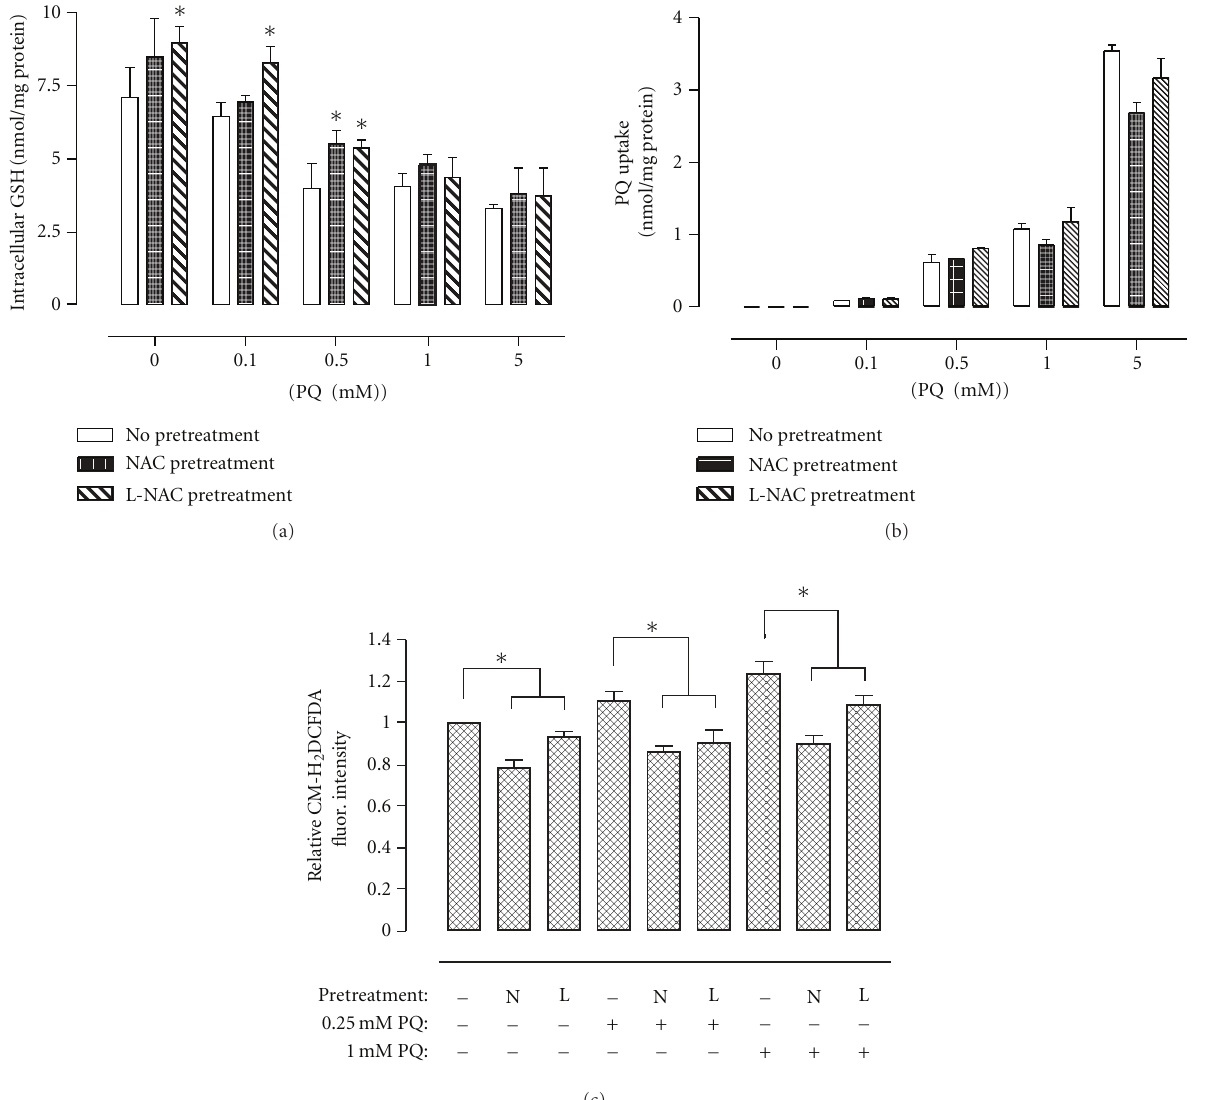
Figure 3: E ff ect of NAC or L-NAC pretreatment on intracellular levels of GSH (a), PQ (b), and ROS (c) in PQ-challenged cells. Cells pretreated for 4 h with control media (No Pretreatment) or 5.0 mM NAC- (NAC Pretreatment) or L-NAC-containing media (L-NAC Pretreatment) were challenged with increasing PQ concentrations (0, 0.1, 0.5, 1.0, and 5.0 mM) for 24 h. Cells were harvested and lysed for concomitant measurement of intracellular GSH content (a) and PQ uptake (b) via UPLC analysis and normalized to total protein. For the measurement of ROS, cells were stained for 30 min posttreatment with the cell permeable CM-H 2 DCFDA fluorescent dye specific for oxidative species. Adherent cells were scraped and analyzed flow cytometrically using the FL1-H channel. Bars represent mean ± S.E.M. of 3 independent experiments. ∗ denotes significant di ff erence relative to cells with no pretreatment ( P < .